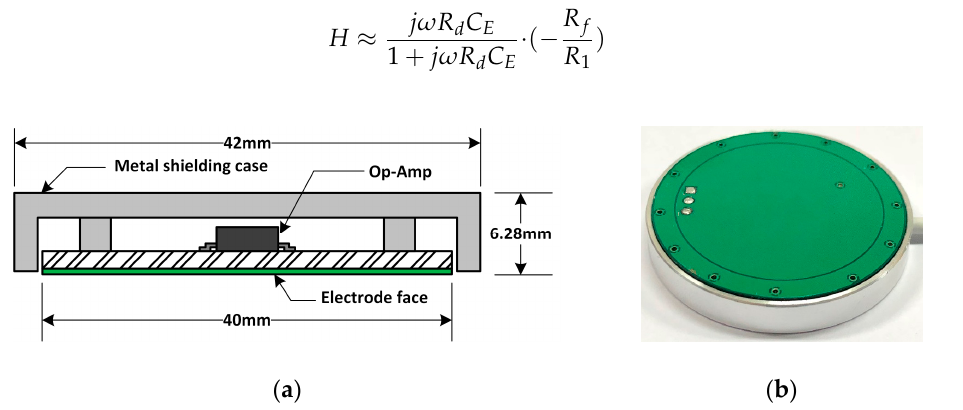
Figure 2. Picture of the sensing electrode: ( a ) Structure diagram; ( b ) The appearance of the electrode.